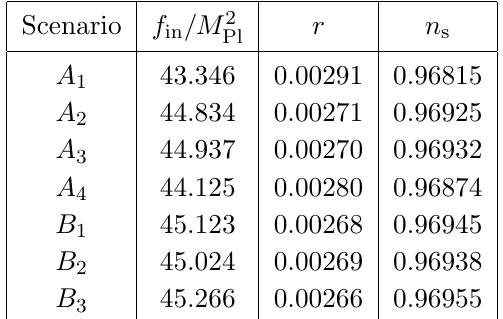
Table 5. The in(cid:13)ationary parameters in the strong coupling approximation calculated at h v = 0, m Z = 0 and m A =